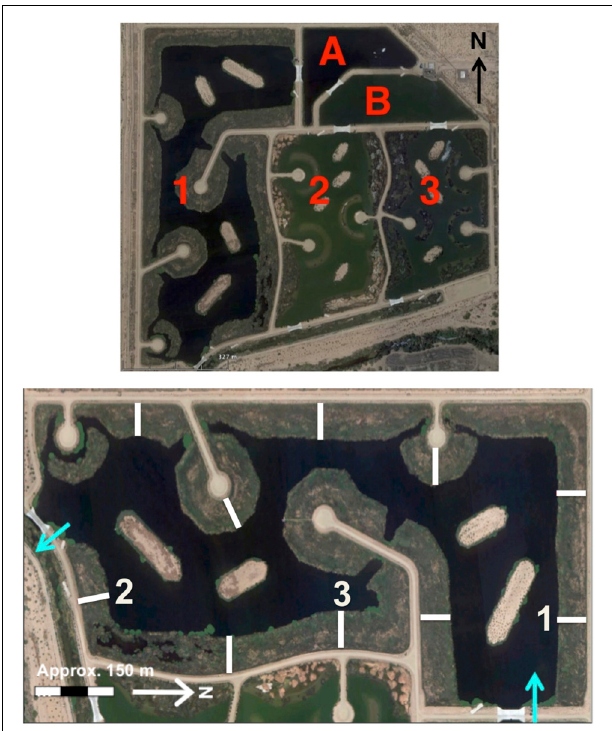
FIGURE 1 | Aerial images of the Tres Rios constructed treatment wetland. (Top) Red letters denote non-vegetated basins that distribute water to the vegetated basins, shown with red numbers (from Weller et al., 2016). (Bottom) Our 42 ha study system is cell number 1 in the top figure. White lines denote the locations of the 10 wetland monitoring transects. Water quality sampling is conducted on the numbered transects, and the inflow and outflow are marked with blue arrows indicating the direction of flow (from Sanchez et al.,